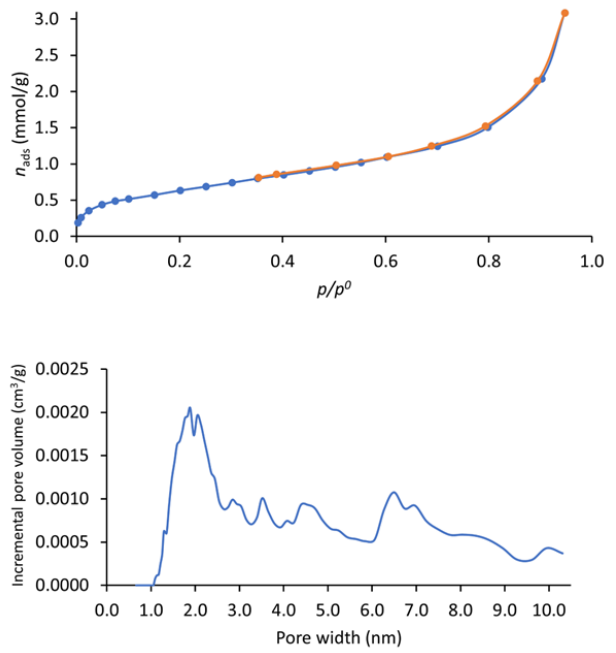
Figure 4. Nitrogen adsorption (in blue)–desorption (in orange) (top) and corresponding pore size distribution curves ( down ) of i ‐ POF.